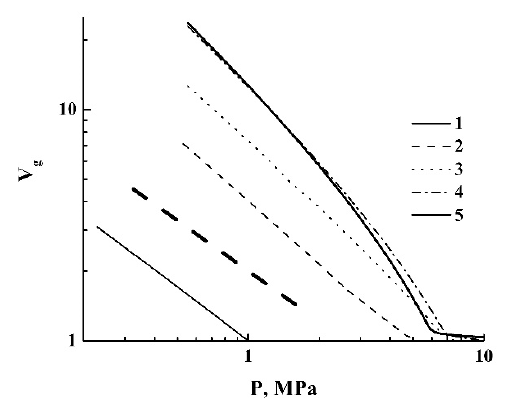
Figure 9. Theoretical adiabatic curves for CO 2 . T s = 309.15 K. P s = : 1–1.0 MPa; 2–5.0 MPa; 3–7.5 MPa; 4–10.0 MPa; 5–15.0 MPa. The bold dashed line is the reference adiabatic curve for an ideal three-atomic gas with the linear geometry of molecules.